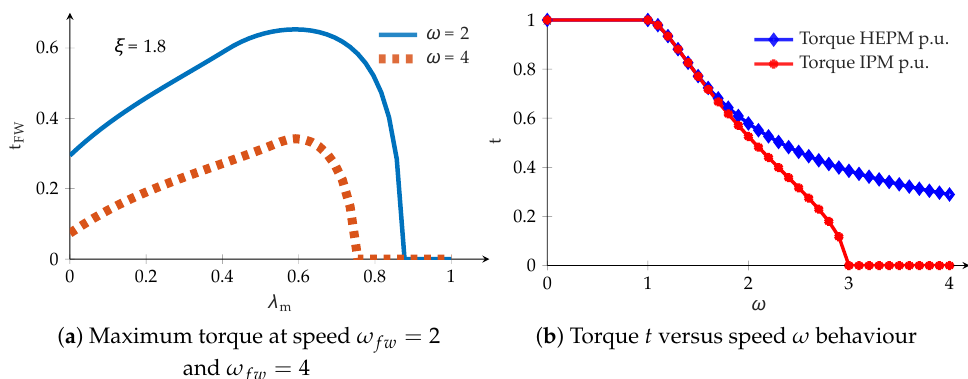
Figure 3. ( a ) Maximum torque that the motor can exhibit during Flux-Weakening (FW) operations according to the parameters and nominal current defined in Figure 2; ( b ) p.u. torque versus p.u. speed behaviors with and without the rotor flux